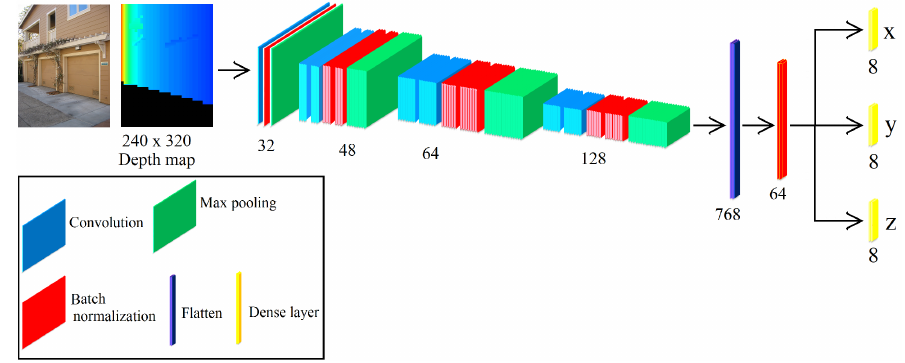
Figure 5. The architecture of our CNN for HLS